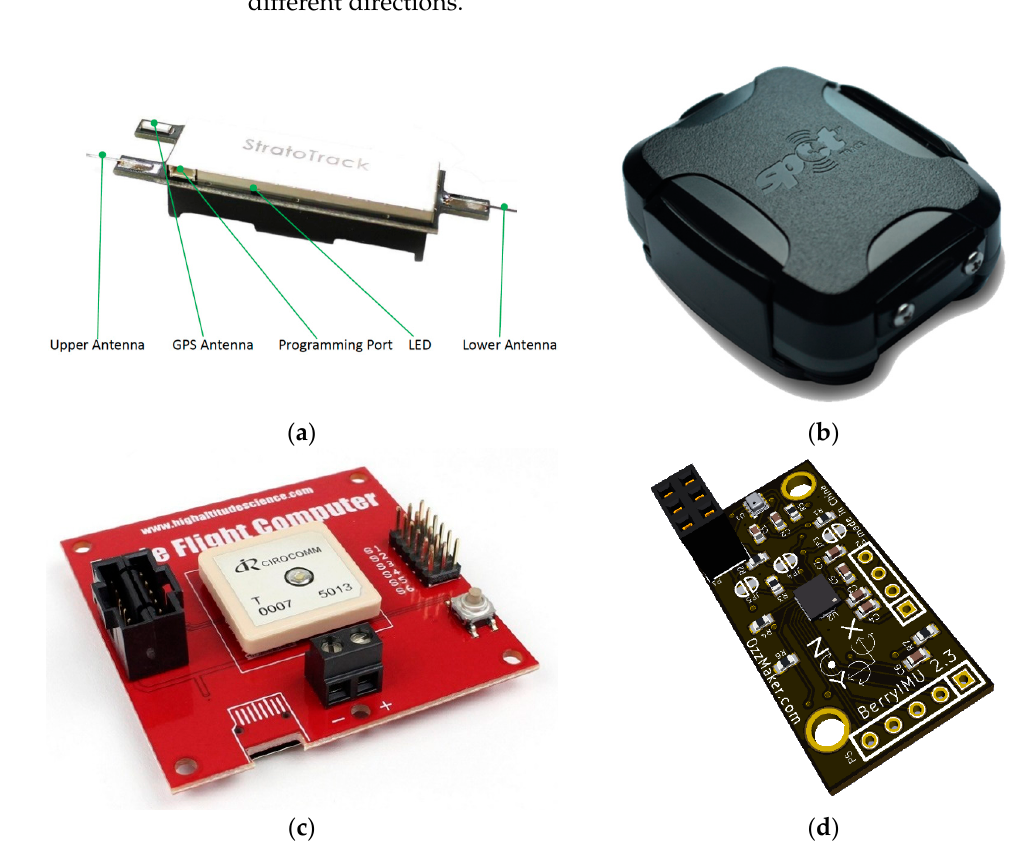
Figure 5. ( a ) Automatic Packet Reporting System (APRS) transmitter, ( b ) SPOT Trace modem, ( c ) EAGLE flight computer, ( d ) Inertial Measurement Unit (IMU) board.